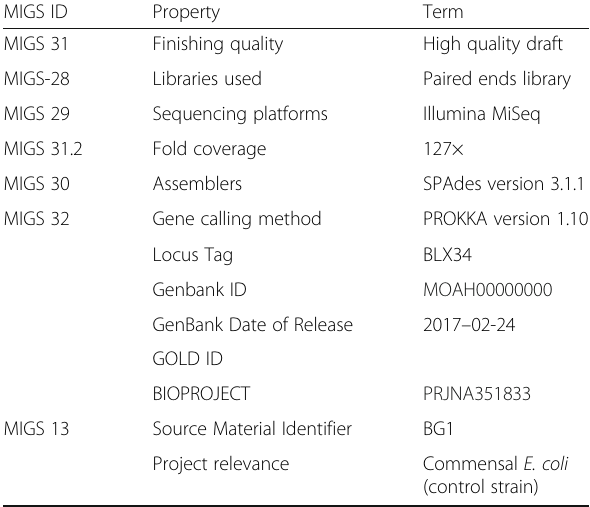
Table 2 Genome sequencing project information for E. coli